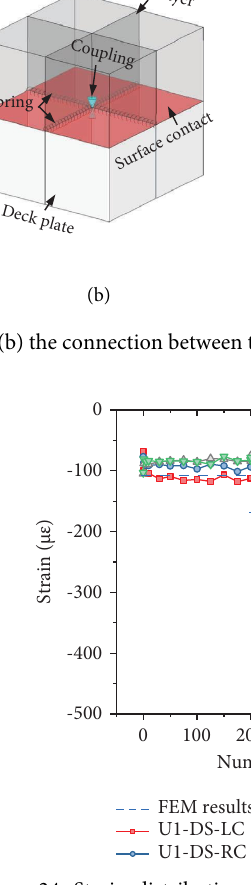
Figure 24: Strain distribution of rib-to-deck joint on transverse